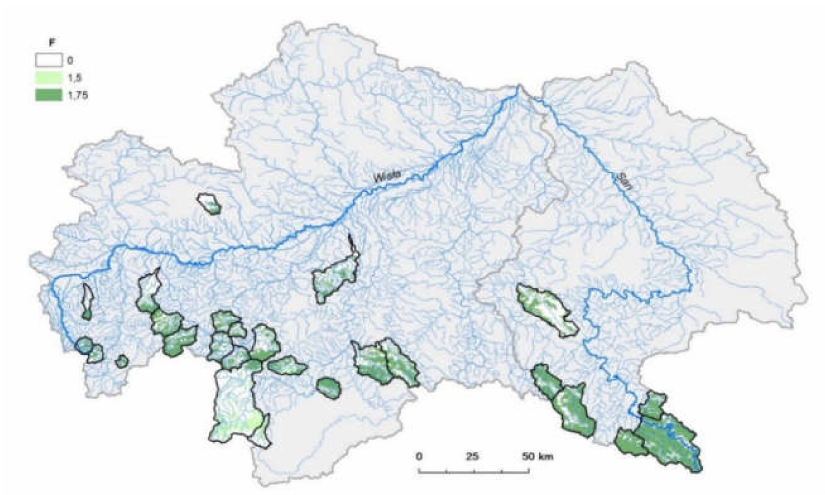
Figure 8. Forest stands ( F ) of analyzed catchments in the Upper Vistula basin.